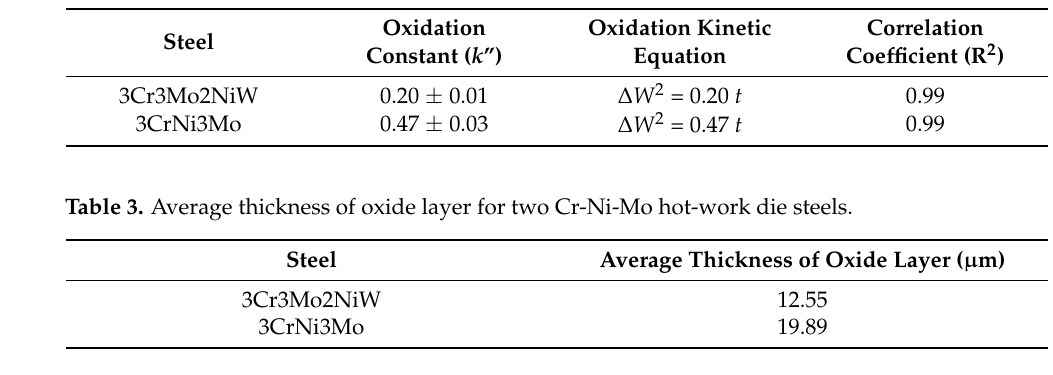
Figure 3. Parabolic rate constants k” of oxidation of two hot-work die steels at 600 ◦ C. The other k” values of hot-work steels were reported by Tilen [28,29], Ziming [30], and Hong [31]. Table 2. Oxidation kinetic equations of two Cr-Ni-Mo hot-work die steels.